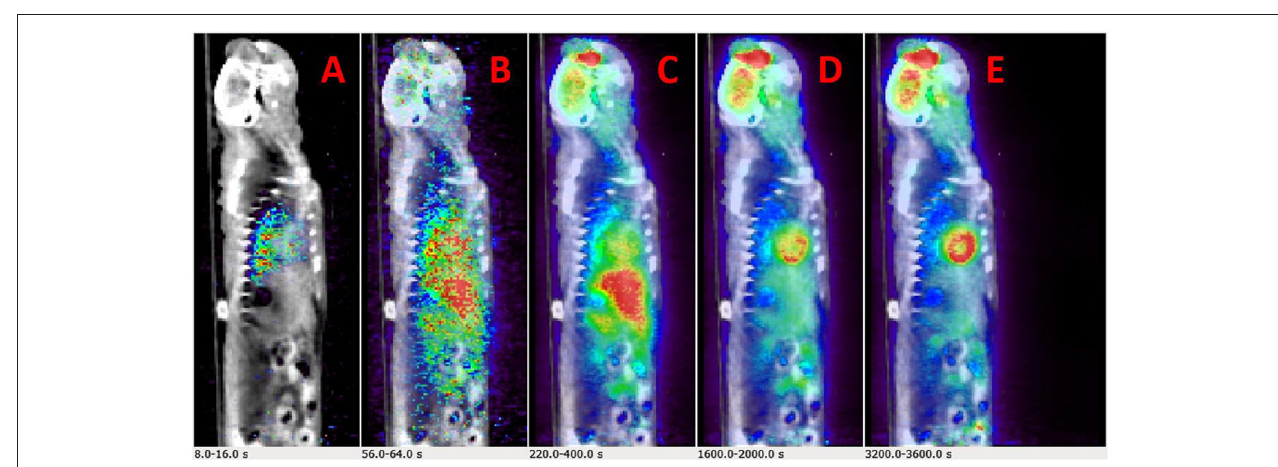
FIGURE 2 | Time-resolved total-body 2-[18F] fluoro-2-deoxy-D-glucose positron emission tomography (FDG PET) images. (A–E) Example PET/CT rendering cut across showing uptake in Wistar–Kyoto (WKY) rat myocardium and brain over a period of 60min.